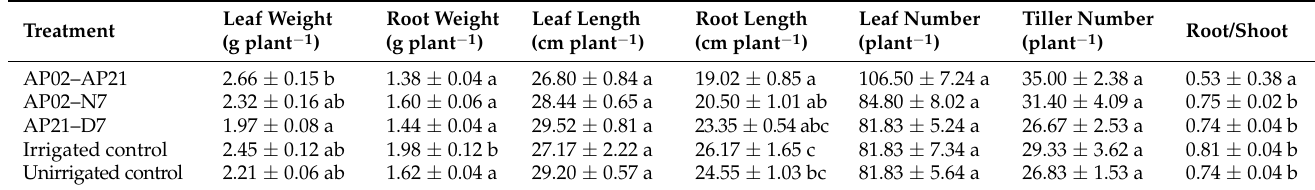
Table 1. Morphological parameters of perennial ryegrass after rehydration. The plants were subjected to 10 days of water deficit and rehydrated for 3 days. Each value represents the mean of the repli- cates from the two independent experiments ± SE. Different letters indicate statistically significant differences observed according to the Fisher’s LSD test with Bonferroni correction ( p < 0.05).